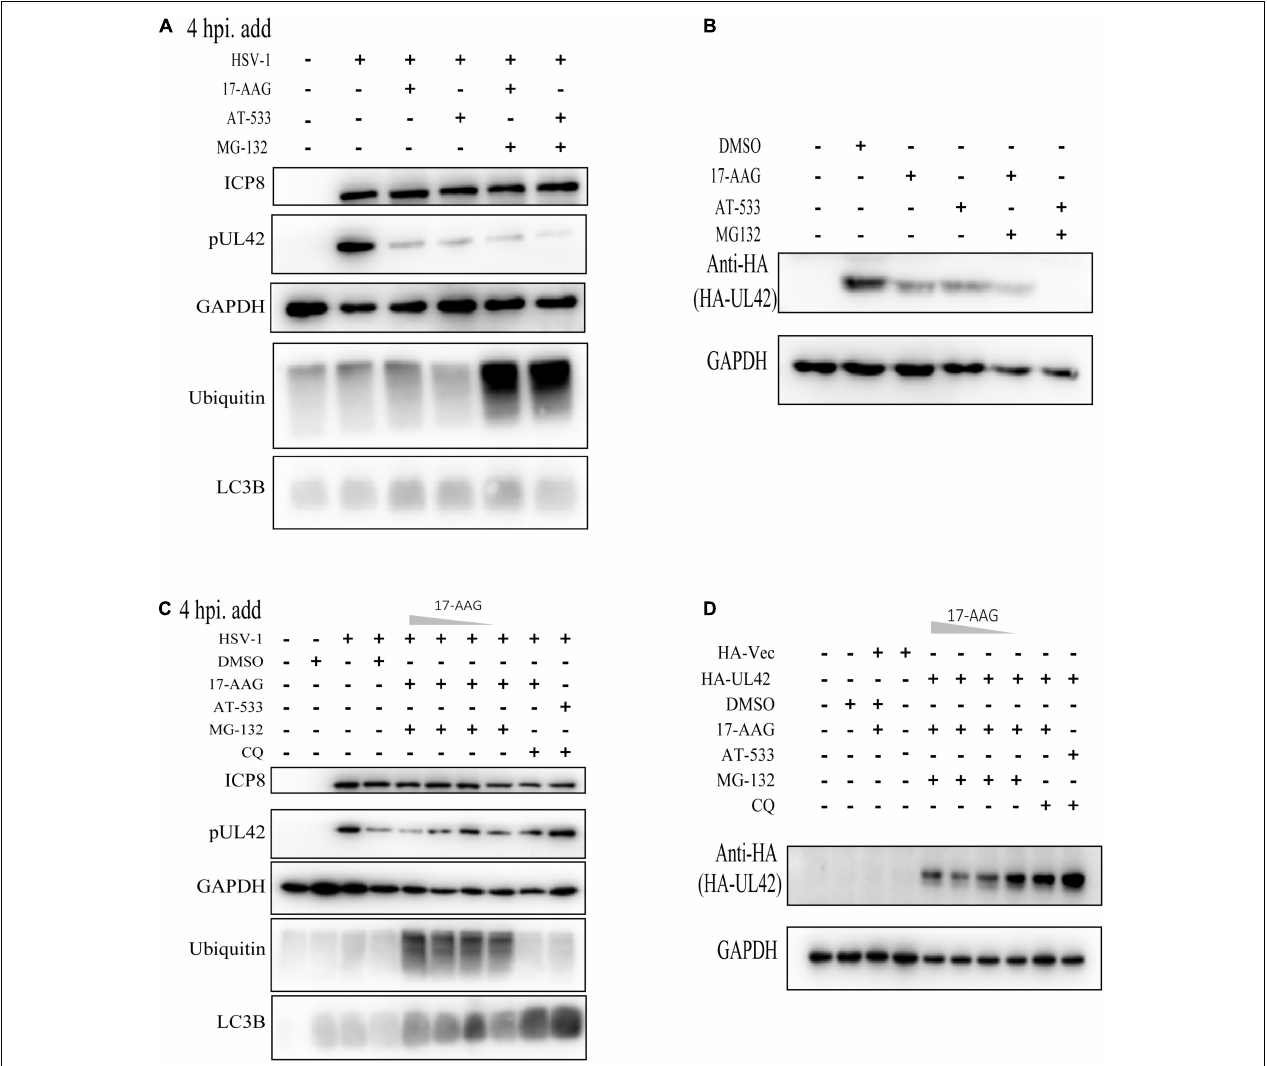
FIGURE 4 | Hsp90 inhibitors mediated autophagy-dependent degradation of UL42. (A) HFF cells were infected with HSV-1 (MOI = 20) and treated with Hsp90 inhibitors and proteasome inhibitor MG-132 (10 µ M) at 4 hpi, and cell lysates were subjected to Western blot assay at 12 hpi. (B) After being transfected with HA-Vector and HA-UL42 plasmid for 48 h, HEK293 cells were refreshed with 2% FBS DMEM containing 1.0 µ M AT-533 or 6.25 µ M 17-AAG and MG132 (10 µ M) at 6 hpi, and cell lysates were subjected to Western blot assay at 12 hpi. (C) HFF cells were infected with HSV-1 (MOI = 20) and treated with different concentrations of Hsp90 inhibitors and proteasome inhibitor MG-132 (10 µ M), autophagy inhibitor CQ (50 µ M), and cell lysates were subjected to Western blot. (D) After transfected with HA-Vector and HA-UL42 plasmid for 48 h, HEK293 cells were refreshed with 2% FBS DMEM containing 1.0 µ M AT-533 or 6.25 µ M 17-AAG and MG132 (10 µ M), autophagy inhibitor CQ (50 µ M) at 6 hpi, and cell lysates were subjected to Western blot assay at 12